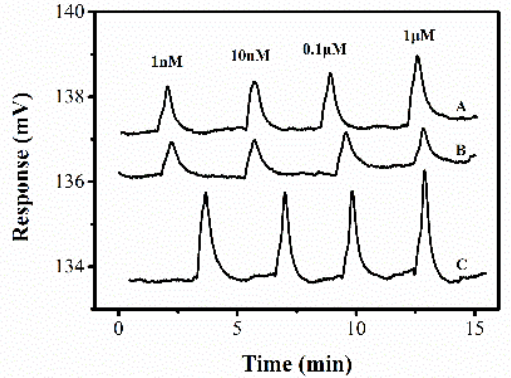
Figure 7. Response of DISODCD (A), DCD (B), and DIC 4 D (C) to 0.001–1 μ M KCl solution.